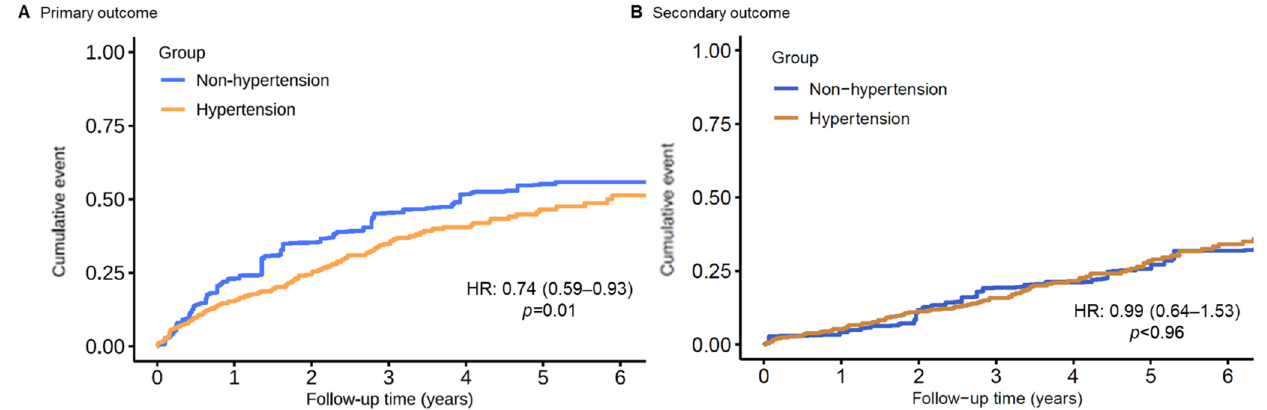
Figure 3. Entropy-balancing weighted Kaplan–Meier time-to-event curves for the cumulative inci- dence of ( A ) primary and ( B ) secondary outcome events for patients with and without hypertension.